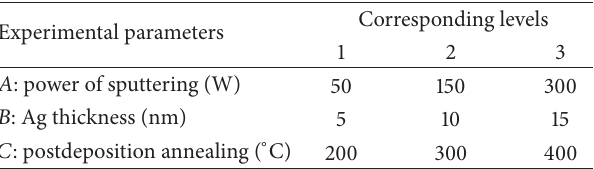
Table 1: Experimental parameters and corresponding levels used in this